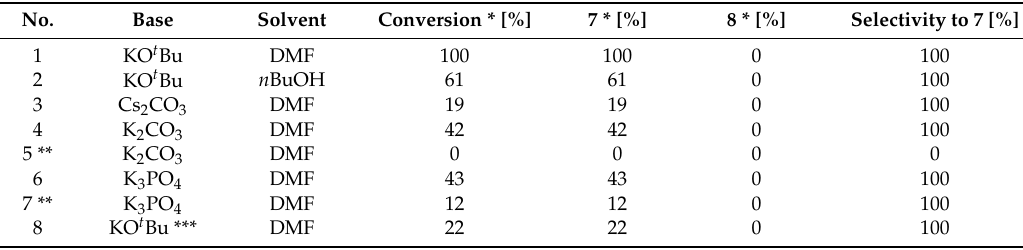
Table 2. Screening of bases and solvent.